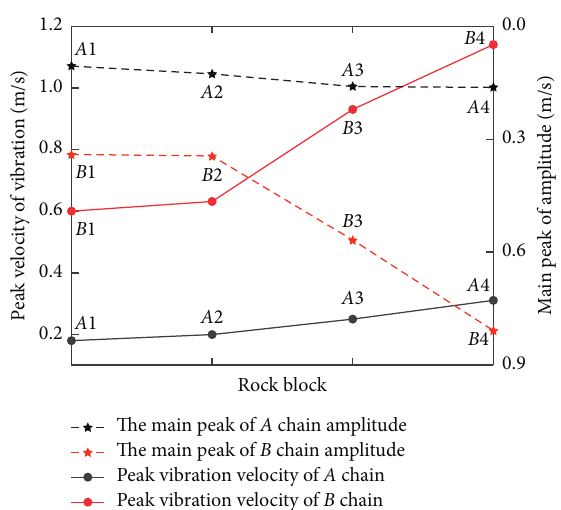
Figure 16: Comparison between the peak vibration velocity and the peak value of amplitude of each monitoring block.